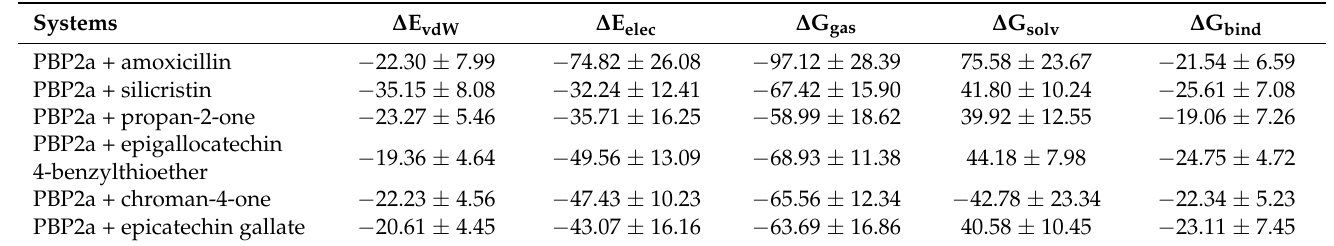
Table 2. Energy components (kcal/mol) of the top-five phenolics against the active site of PBP2a of S. aureus